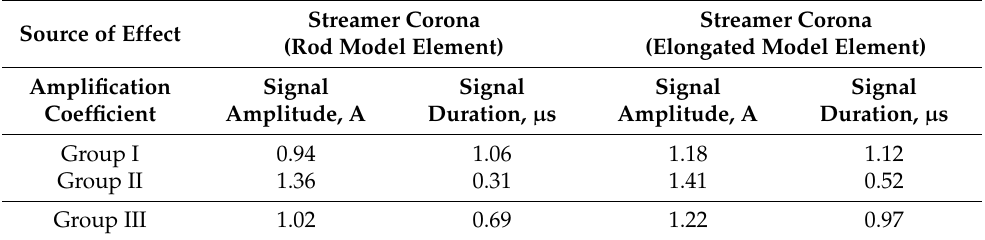
Table 3. Characteristics of the signals induced with nearby impulse streamer corona on the model elements (average values).